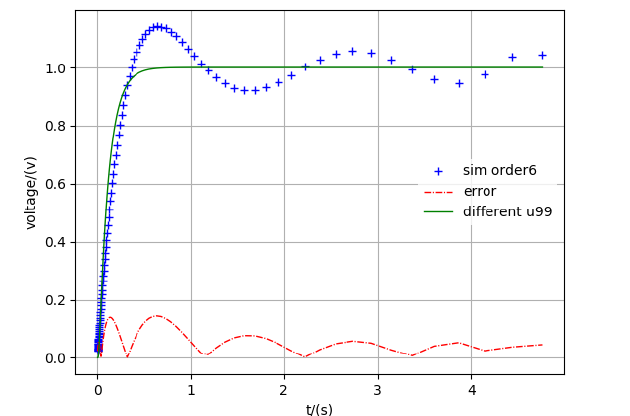
Figure 7. Simulation six-order.